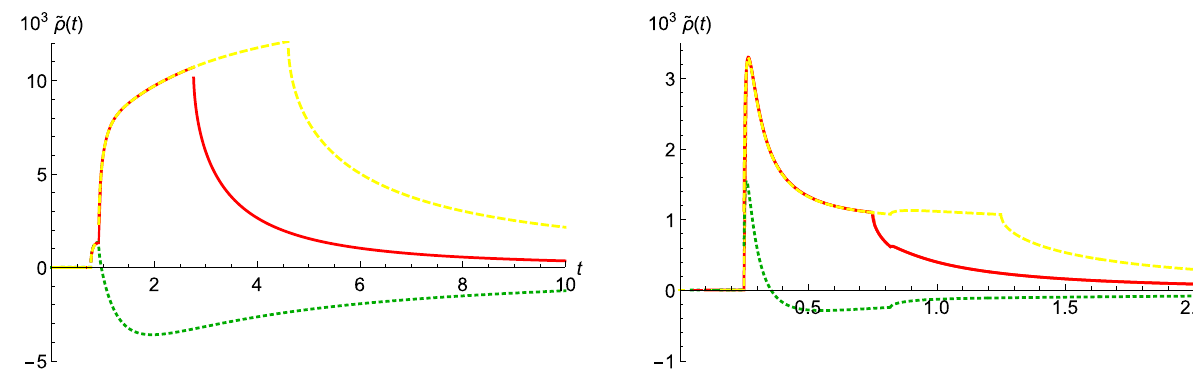
Fig. 2 Spectral functions for the propagator (cid:2) h ( p ) h ( − p ) (cid:3) , for ξ = 1 (green, dotted), ξ = 3 (red, solid), ξ = 5 (yellow, dashed), with t given in units of μ 2 , for Region I (left) and Region II (right) with the parameter values given in Table 1